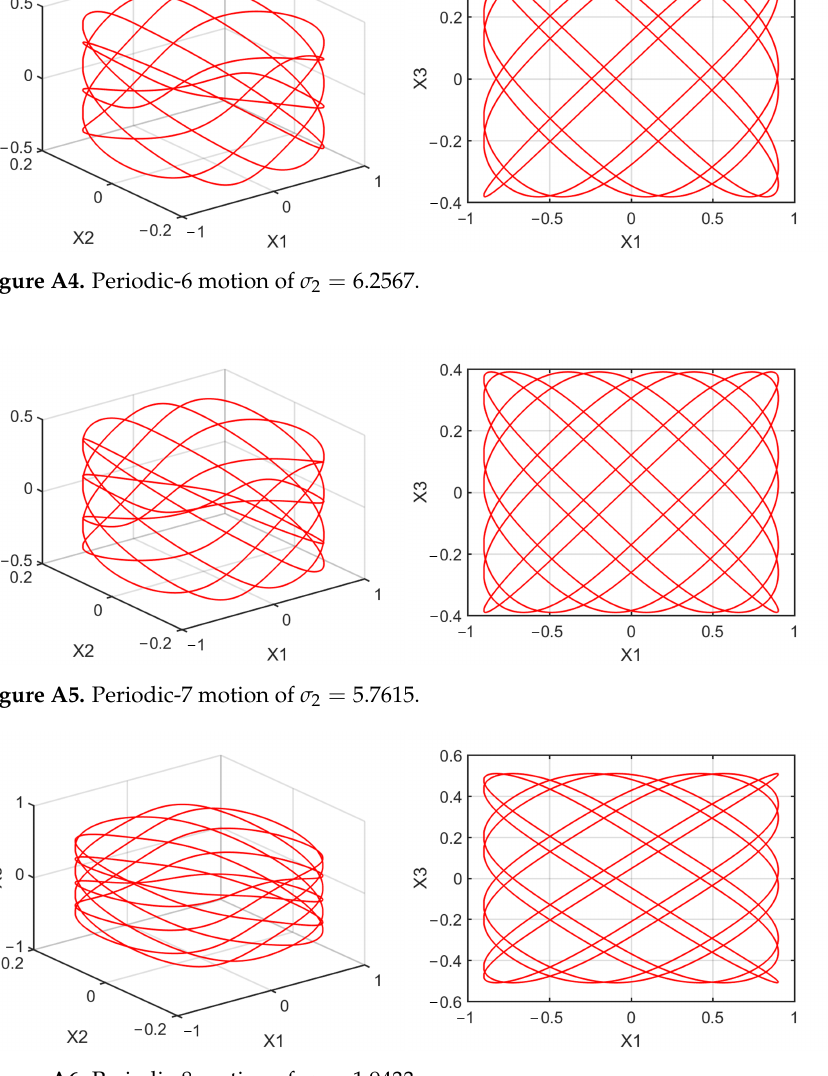
Figure A6. Periodic-8 motion of σ 2 =